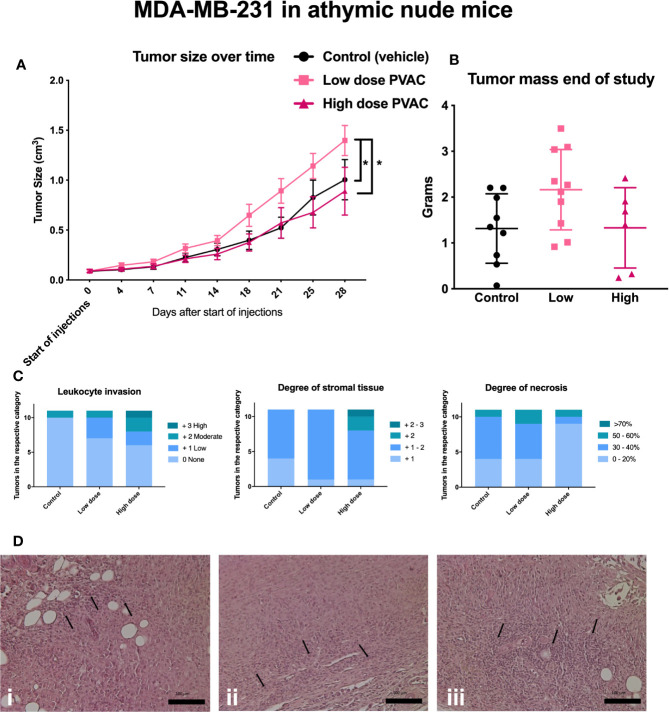
Athymic nude mice were inoculated with MDA-MB-231 tumor cells and subjected to intratumoral polyvinyl alcohol carbazate (PVAC) (high or low dose) or vehicle injections. (A) Injections over time, each tick represents new injection. After 21, 25, and 28 days the tumor volume was significantly higher in the PVAC low dose group when compared to the control and the high dose group (at 28 days p < 0.05 mean 0.39 cm3 CI 95% 0.13–0.66 and p < 0.05 mean 0.51 cm3 CI 95% 0.21–0.8, respectively). No other differences between the groups were noted. (B) shows tumor mass at the end of the study. No significant difference between the groups was noted. (C) Scored leukocyte infiltration, stromal tissue and necrosis; no significant differences were noted. (D) Shows histological slides of tumors, i control (vehicle), ii low dose PVAC, iii high dose PVAC. Arrows indicate leukocytes.